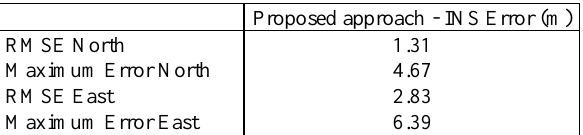
Table 3. Proposed approach performance errors during 60 Secs of GNSS signal